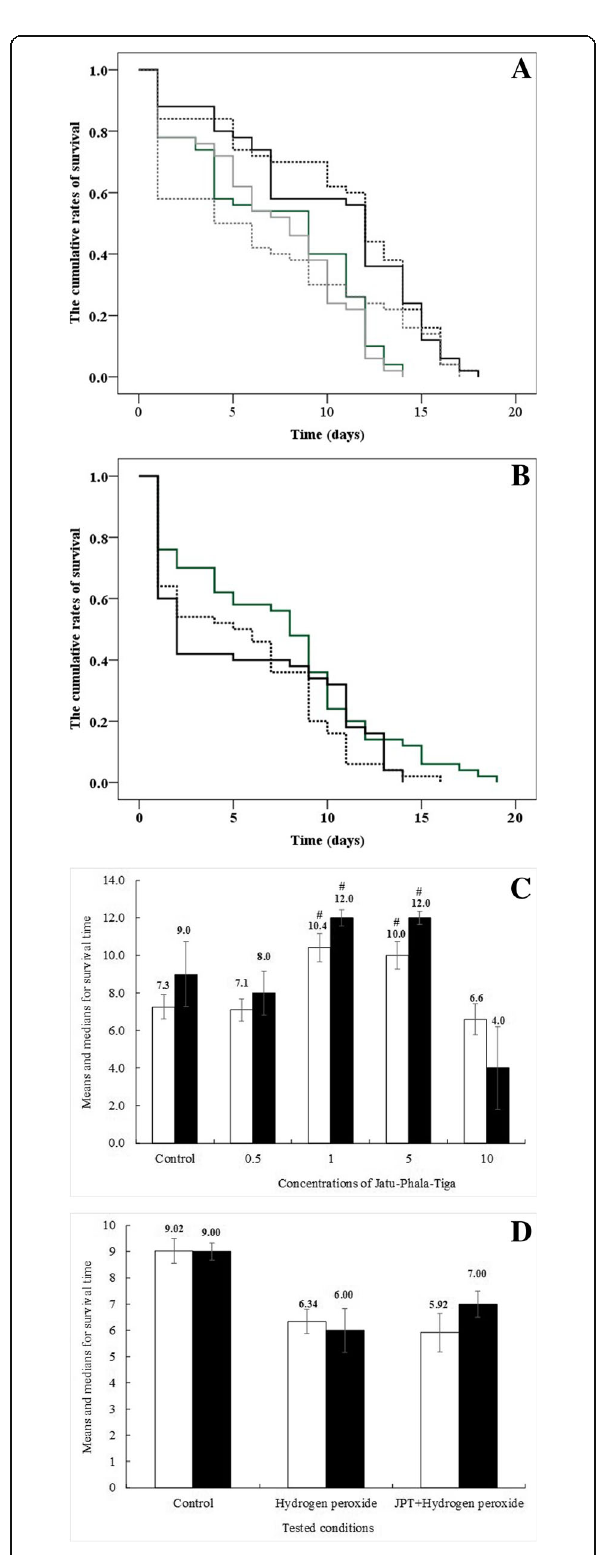
Fig. 3 Kaplan-Meier survival estimates the effect of different concentrations of Jatu-Phala-Tiga (JPT) water extract on the means and median lifespan of wild-type Caenorhabditis elegans under ( a ) the normal condition (untreated control; green line, treated with JPT at 0.5mg/mL; grey line, 1mg/mL; broken black line, 5mg/mL; black line, and 10mg/mL; dark broken grey line,) and ( b ) H 2 O 2 -induced oxidative stress condition (untreated control; green line, H 2 O 2 exposed control; broken black line, H 2 O 2 exposed and treated with 5mg/mL of JPT; black line). The mean lifespan (white bars) and the median survival time (black bars) of the nematodes ( n =50 – 100) under the normal condition ( c ) and H 2 O 2 -induced oxidative stress condition ( d ) were calculated from three independent experiments. p <0.05 were considered as significantly different from untreated control group by the Log-rank (Mantel-Cox)